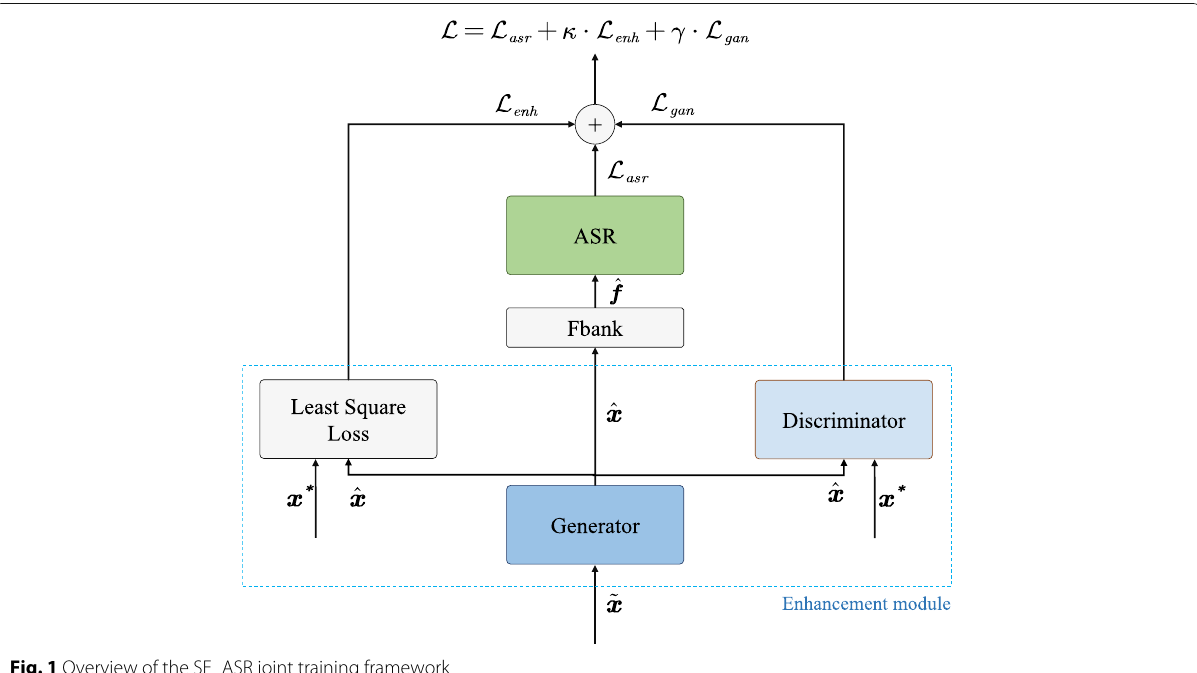
Fig. 1 Overview of the SE_ASR joint training